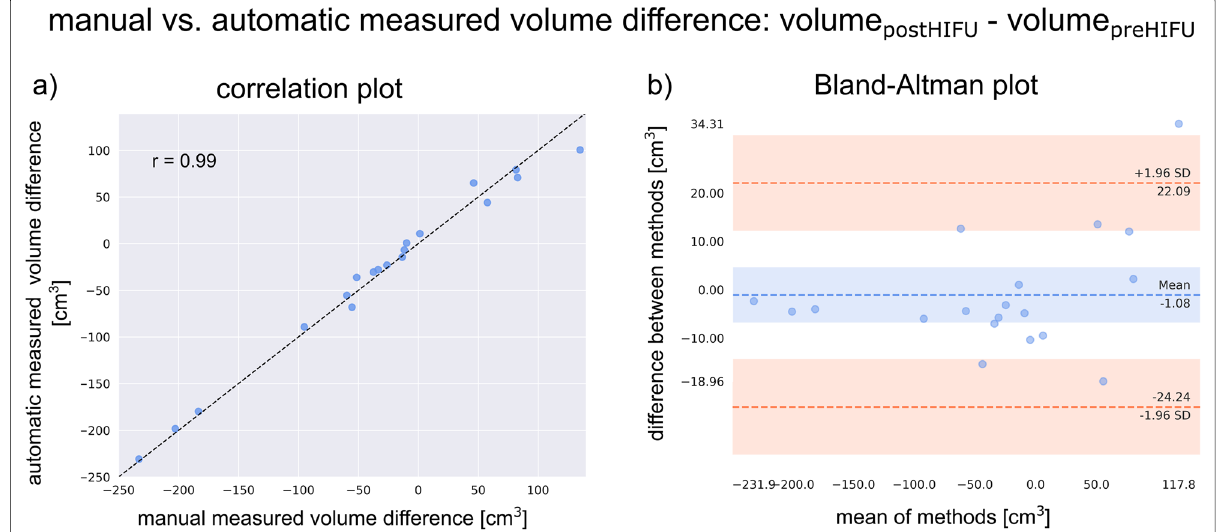
Fig. 4 Scatterplot with Pearson correlation coefficient ( a ) and Bland–Altman plot ( b ) for agreement analyses between automatic measured volume difference and ground truth before and after HIFU